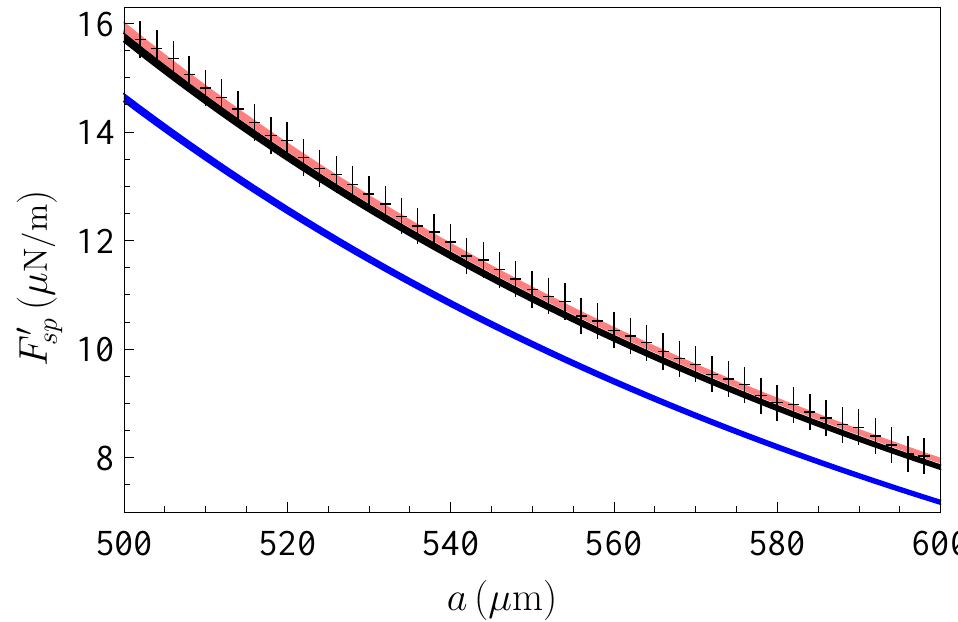
Figure 8. The gradients of the Casimir force between an Au-coated sphere and an Au-coated plate measured by means of a micromechanical torsional oscillator [22] (crosses) are compared with theoretical predictions of Lifshitz theory using extrapolation of the optical data of Au by means of the nonlocal Drude-like response functions (black band). The theoretical predictions using the Drude and plasma extrapolations are indicated by the blue and red bands, respectively.